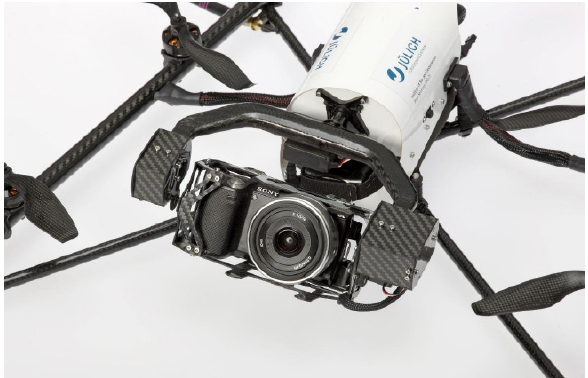
Figure 3. Sony Alpha 6000 camera attached to the Falcon-8 Octocopter.